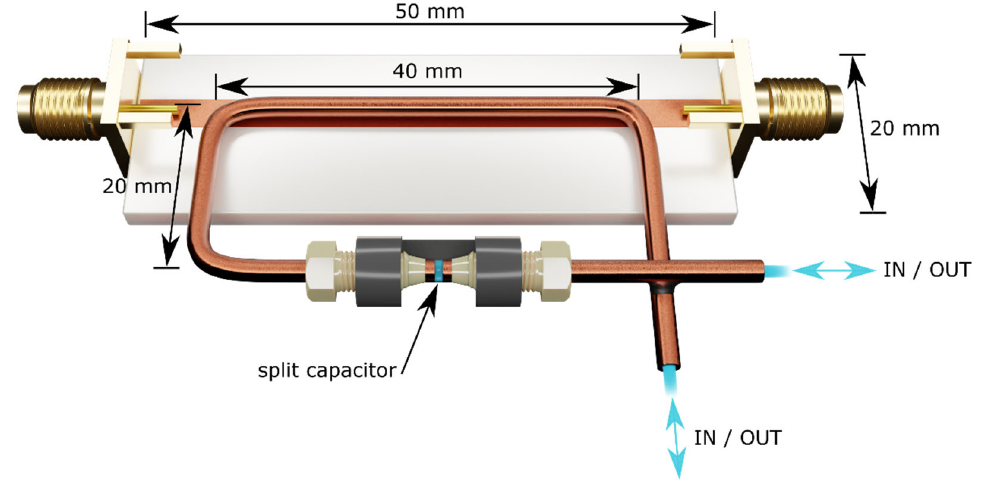
Figure 1. Schematic of the capillary split ‐ ring resonator (CaSRR) with a transmission line on RO4003C PCB and a split ‐ ring made of copper capillaries. The split capacitor is formed inside a Vici Valco PEEK union with an inner diameter of 1.6 mm by the two opposite capillary endings.